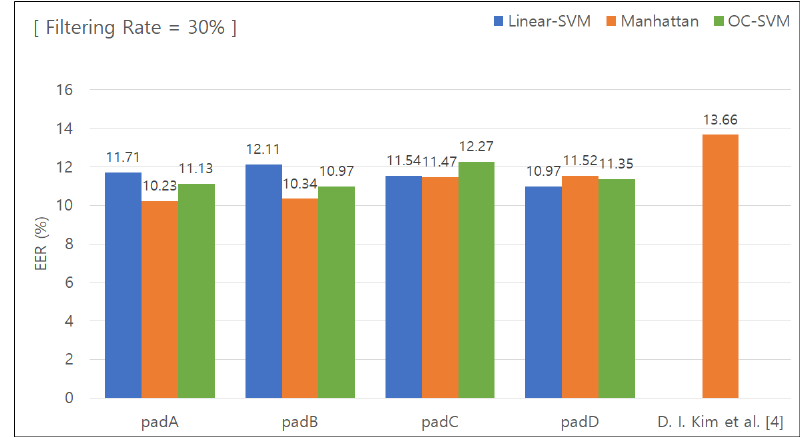
Figure 8. EER for removal of the lower 30% features.